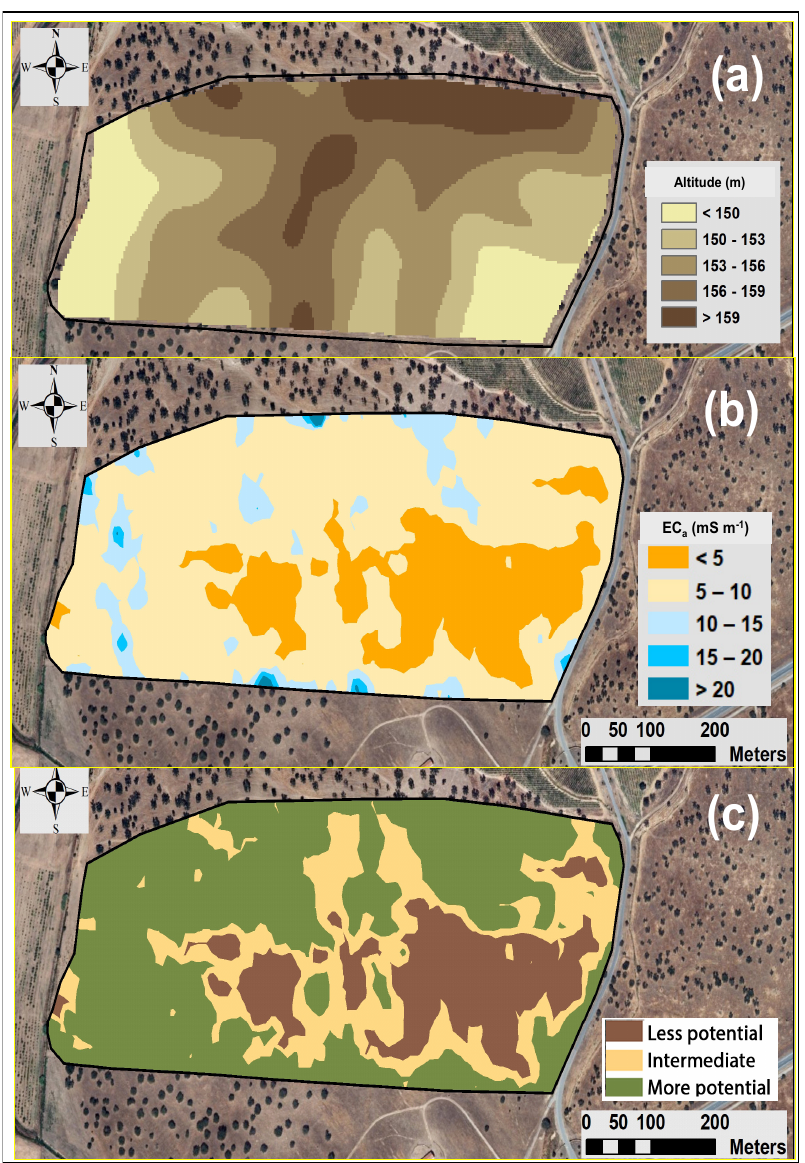
Figure 8. Altitude ( a ), soil apparent electrical conductivity (EC a ; ( b )) and homogeneous management zones ( c ) of “Grous” experimental field.